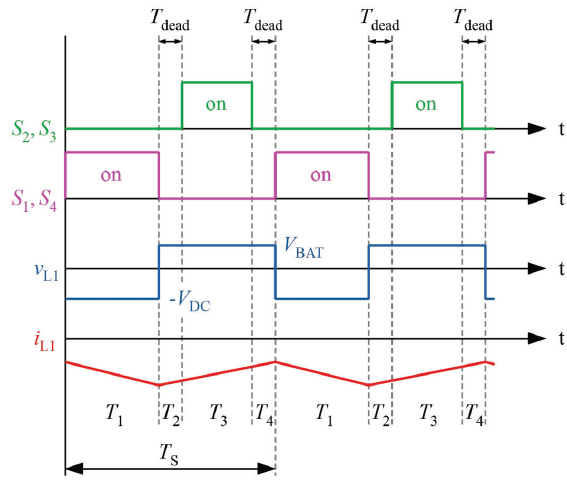
Figure 21. Active switch states, inductor voltages and inductor currents for DC2B mode.